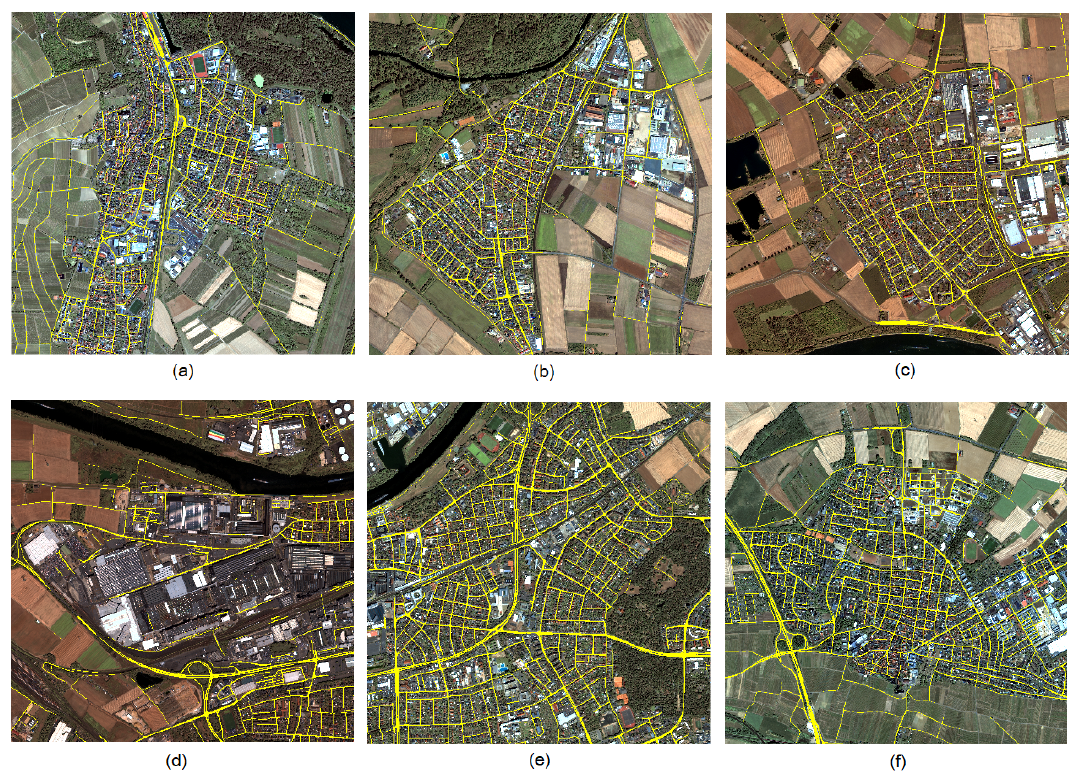
Figure 3. Detected road masks of the six test regions Figure. 3. These regions feature various types of roads, from asphalted streets to country roads as well as highways, with dif- ferent widths and surrounded by a variety of contexts like res- idential buildings, commercial and industrial areas, fields and forests. Despite the challenges posed by these widely differ- ent scenarios, the model demonstrated an equally good per- formance on each of them. The extracted roads match match the real-world topology in, width, smoothness and connectivity across all images. A confusion with railways is visible in im- age Figure. 3 (d) where a few road segments were wrongly pre- dicted, but this is a know issue of such model. Models